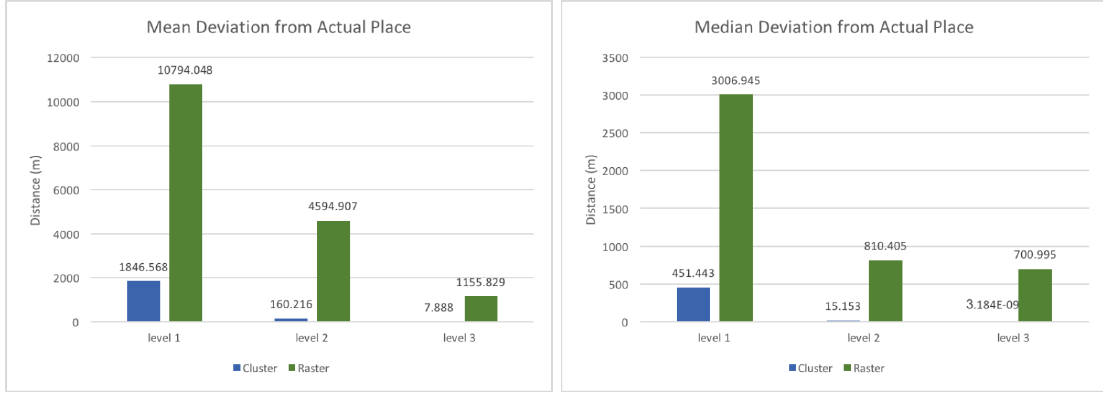
Figure 6. Distance deviation of the exact coordinate prediction from the actual longitude/latitude on the different levels. The average distances reflect the much larger cluster and cell size on level 1 and 2.